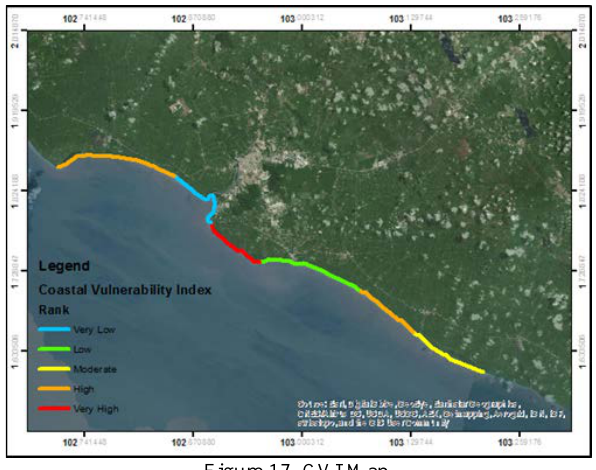
Figure 17. CVI Map